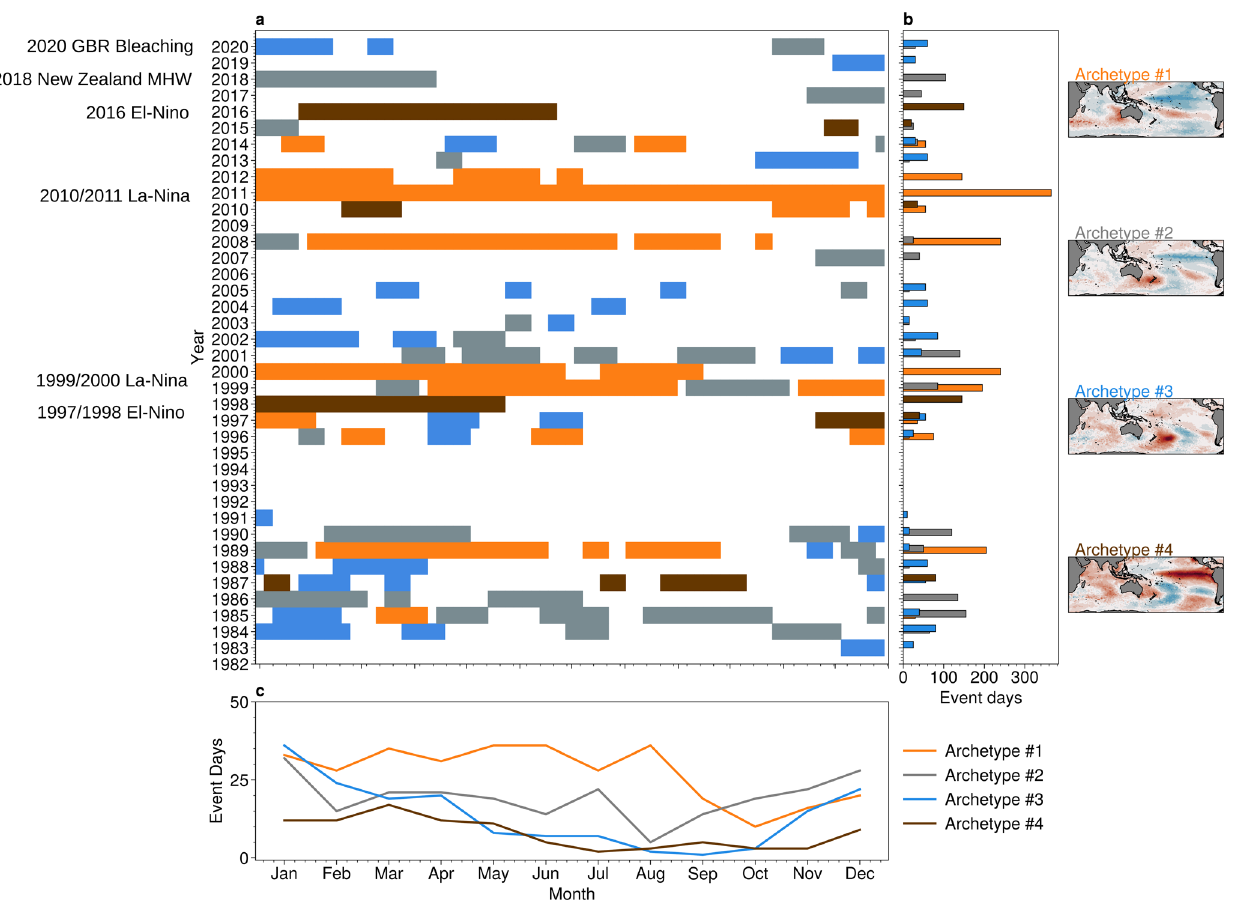
Fig. 2 | Temporal regimes of archetypal patterns. a Coloured blocks indicate periods where a particular archetype was dominant for at least 20 days. The y -axis indicates the year, while the x -axis indicates the calendar day-of-year. Blanked periods show days where no qualifying event was found; the total number of